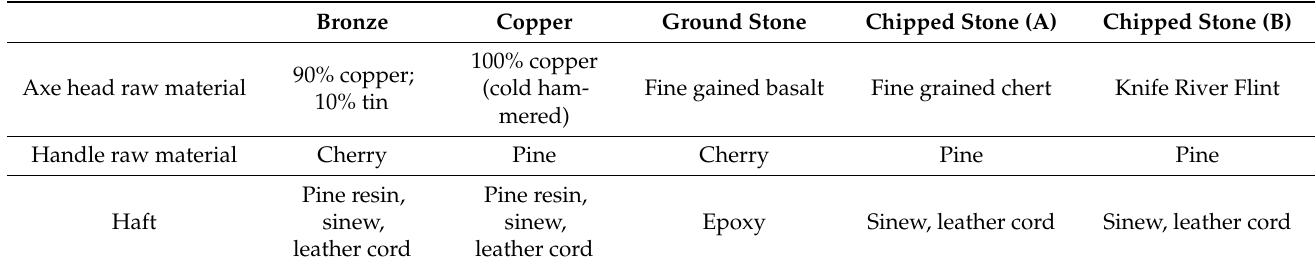
Figure 2. EBII Ground stone axe recovered from Demircihöyük–Sarıket cemetery. Image reproduced from Massa (2014) with permission from Cambridge University Press. Table 1. Construction materials and techniques used for the experimental axes.